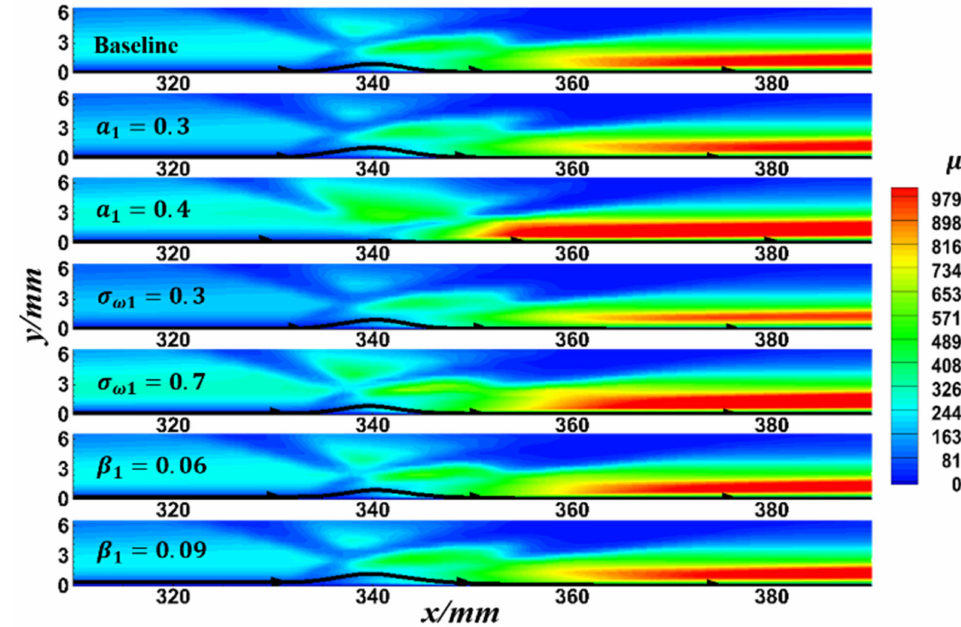
Figure 14. Eddy viscosity contour for test cases.